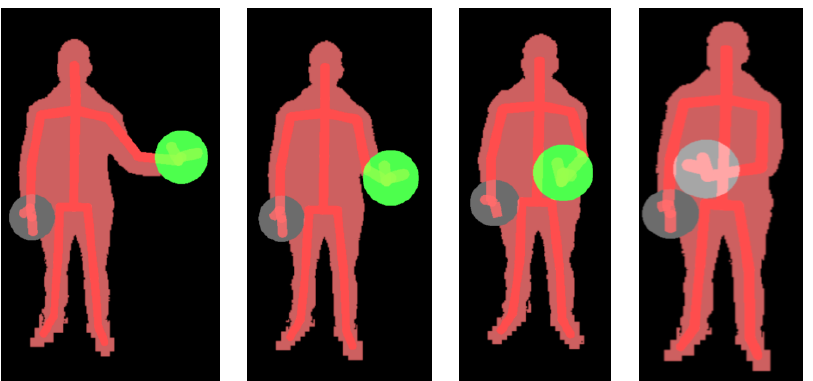
Figure 12. Gesture recognition: from left to right, the circle represents the tracking of the hand from one side to the other. The gray circle indicates that the final pose has been identified.